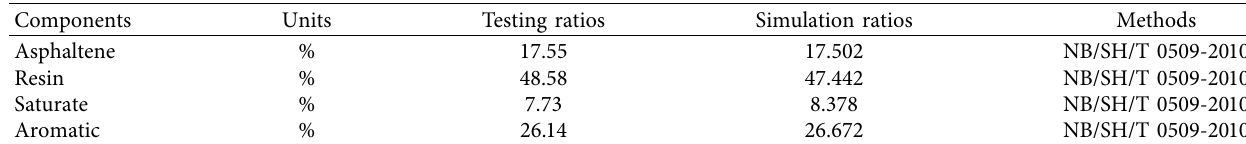
Table 3: Ratios of asphalt four-component